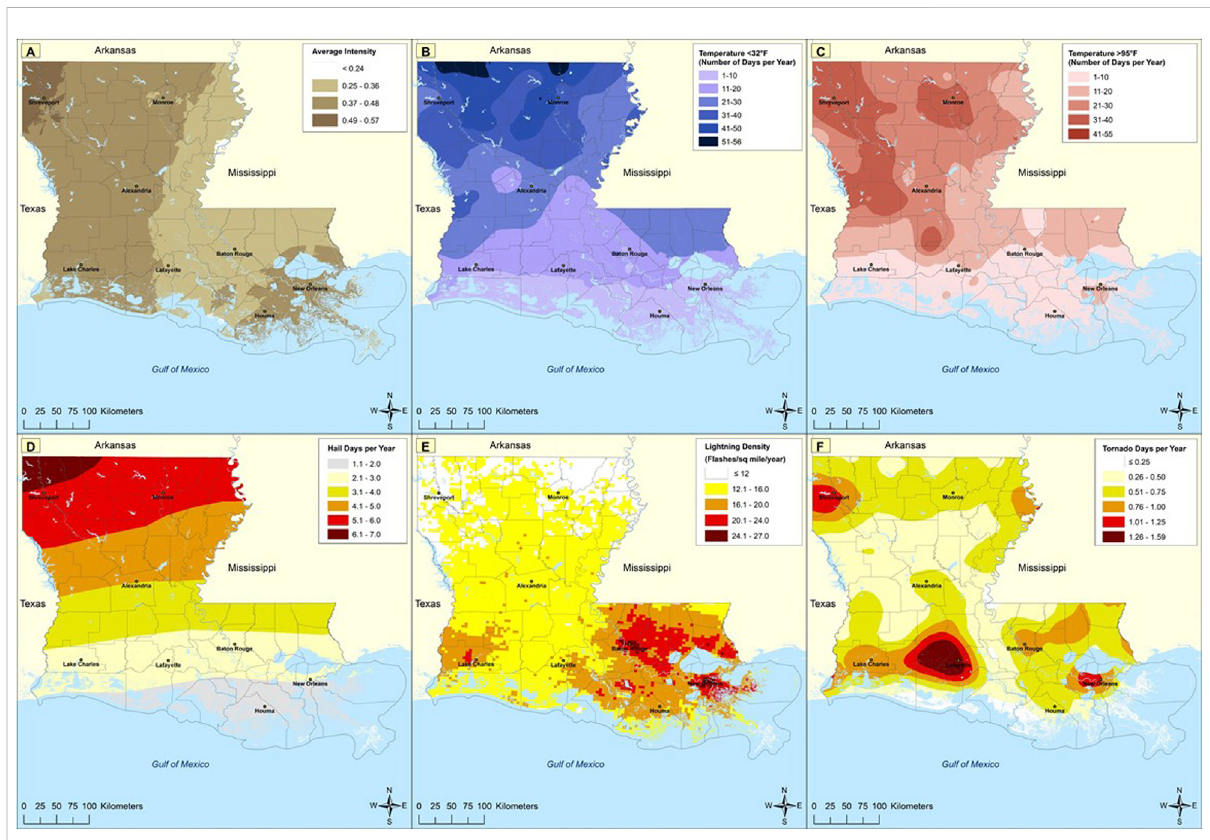
FIGURE 2 Historical mean hazard intensity ( H j ) in Louisiana: (A) drought (2000 ─ 2017), (B) extreme cold temperature (1992 ─ 2017; Mosta fi z et al., 2020b), (C) extreme heat (1992 ─ 2017), (D) hail (1982 ─ 2011; Mosta fi z et al., 2020b), (E) lightning (1986 ─ 2012; Mosta fi z et al., 2020b), and (F) tornado (1950 ─ 2016; Mosta fi z et al.,